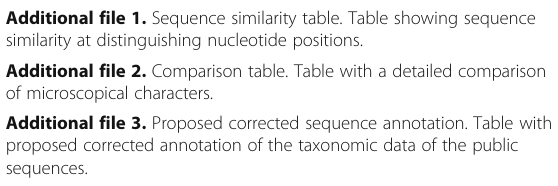
Additional file 1. Sequence similarity table. Table showing sequence similarity at distinguishing nucleotide positions. Additional file 2. Comparison table. Table with a detailed comparison of microscopical characters. Additional file 3. Proposed corrected sequence annotation. Table with proposed corrected annotation of the taxonomic data of the public